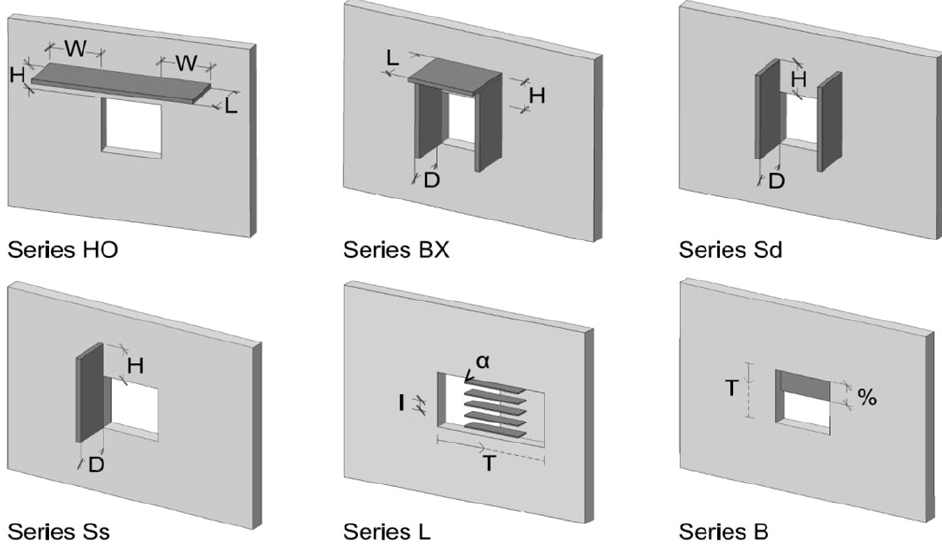
Figure 4. Geometric dimensions of the solar protection elements.